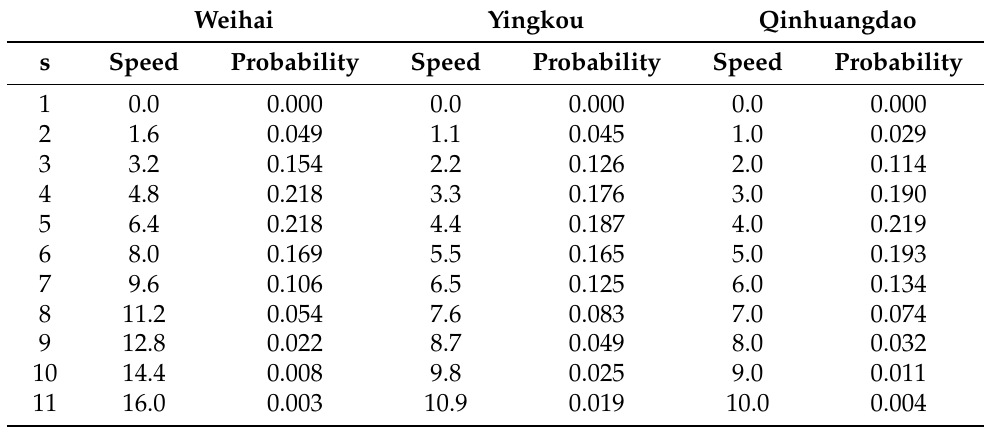
Figure 6. Cumulative distribution function of wind speed at different locations. Table 4. Probability sequences of wind speed at various